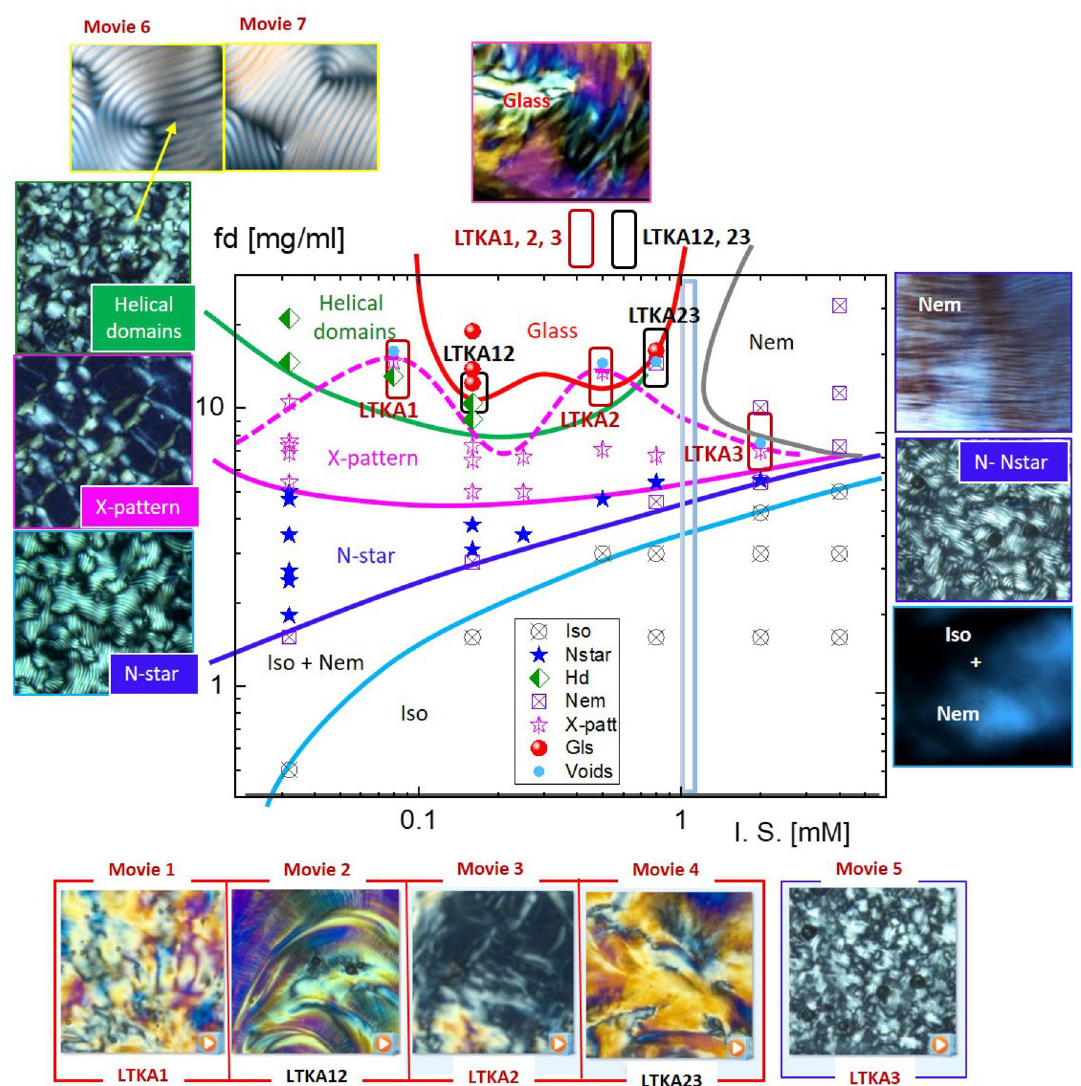
Figure 2. The equilibrium phase diagram and the corresponding optical morphologies of charged fibrous viruses (fd) as a function of fd-concentration and ionic strength (below 4 mM salt): The various phases are indicated as Iso: isotropic, Iso + Nem: isotropic-nematic coexistence, N-star: chiral-nematic (N*), X-pattern, helical domains ( H D ), and glass. The phase lines are guided for each observed phase data point. Near the glass, the fluctuating X-pattern exists with mixed states of helical domains and occasional “voids”. A few locations of long-time kinetic arrest (LTKA) are indicted as LTKA1, LTKA2, LTKA3, LTKA12, and LTKA23 near high concentrations that exceed the phase boundary in the diagram. Note that LTKA3 is located at a lower concentration, compared to other LTKAs at higher ionic strength. Supplementary data movies are provided in Movies 1, 2, 3, 4 and 5 for LTKAs, as well Movies 6 and 7 for existing slow dynamics of microscopic views of helical domains respectively, via ImageJ software version ImageJ 1.52i in the URL link https ://image